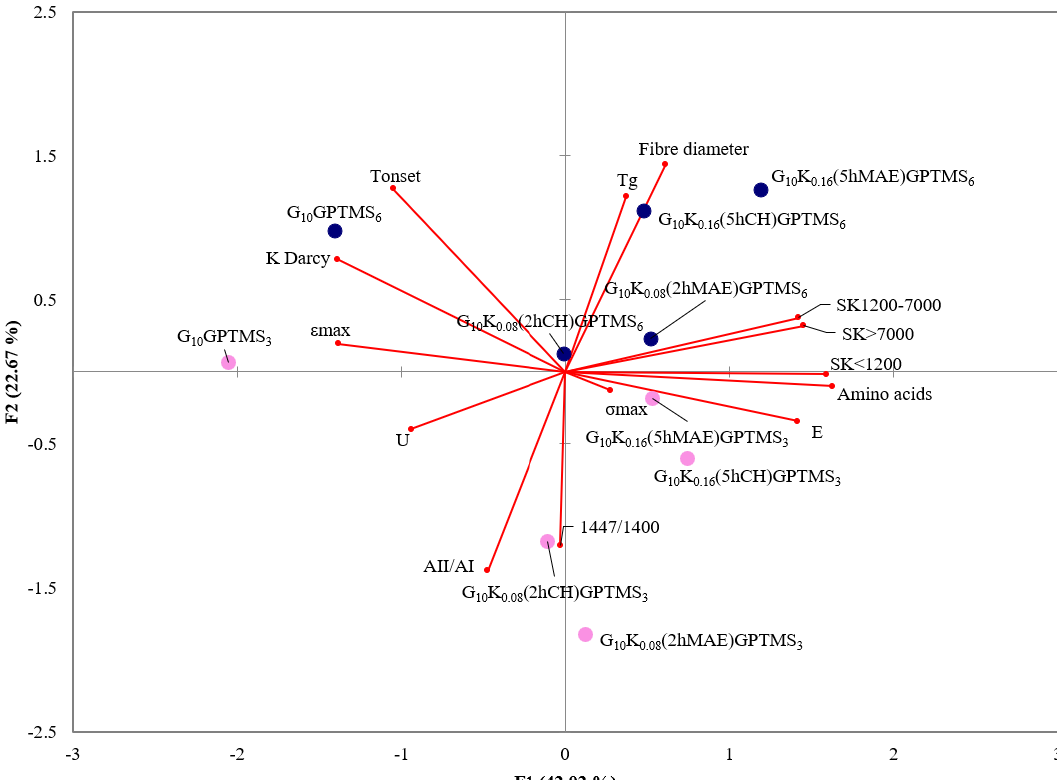
Figure 4. PCA biplot. The circular dots (pink 3% GPTMS and blue 6% GPTMS) illustrating all the observations (score plot), and the red vectors showing the variables (loading plot): failure stress ( σ max ), failure strain ( ε max ), elastic modulus (E), toughness (U), water permeability (K Darcy), fiber diameter, glass transition temperature (T g ), onset temperature (T onset ), the ratio of optical densities of amide II and amide I bands (AII/AI), and the ratio of two bands characteristic of CH 2 bending (δ1447/δ1400).